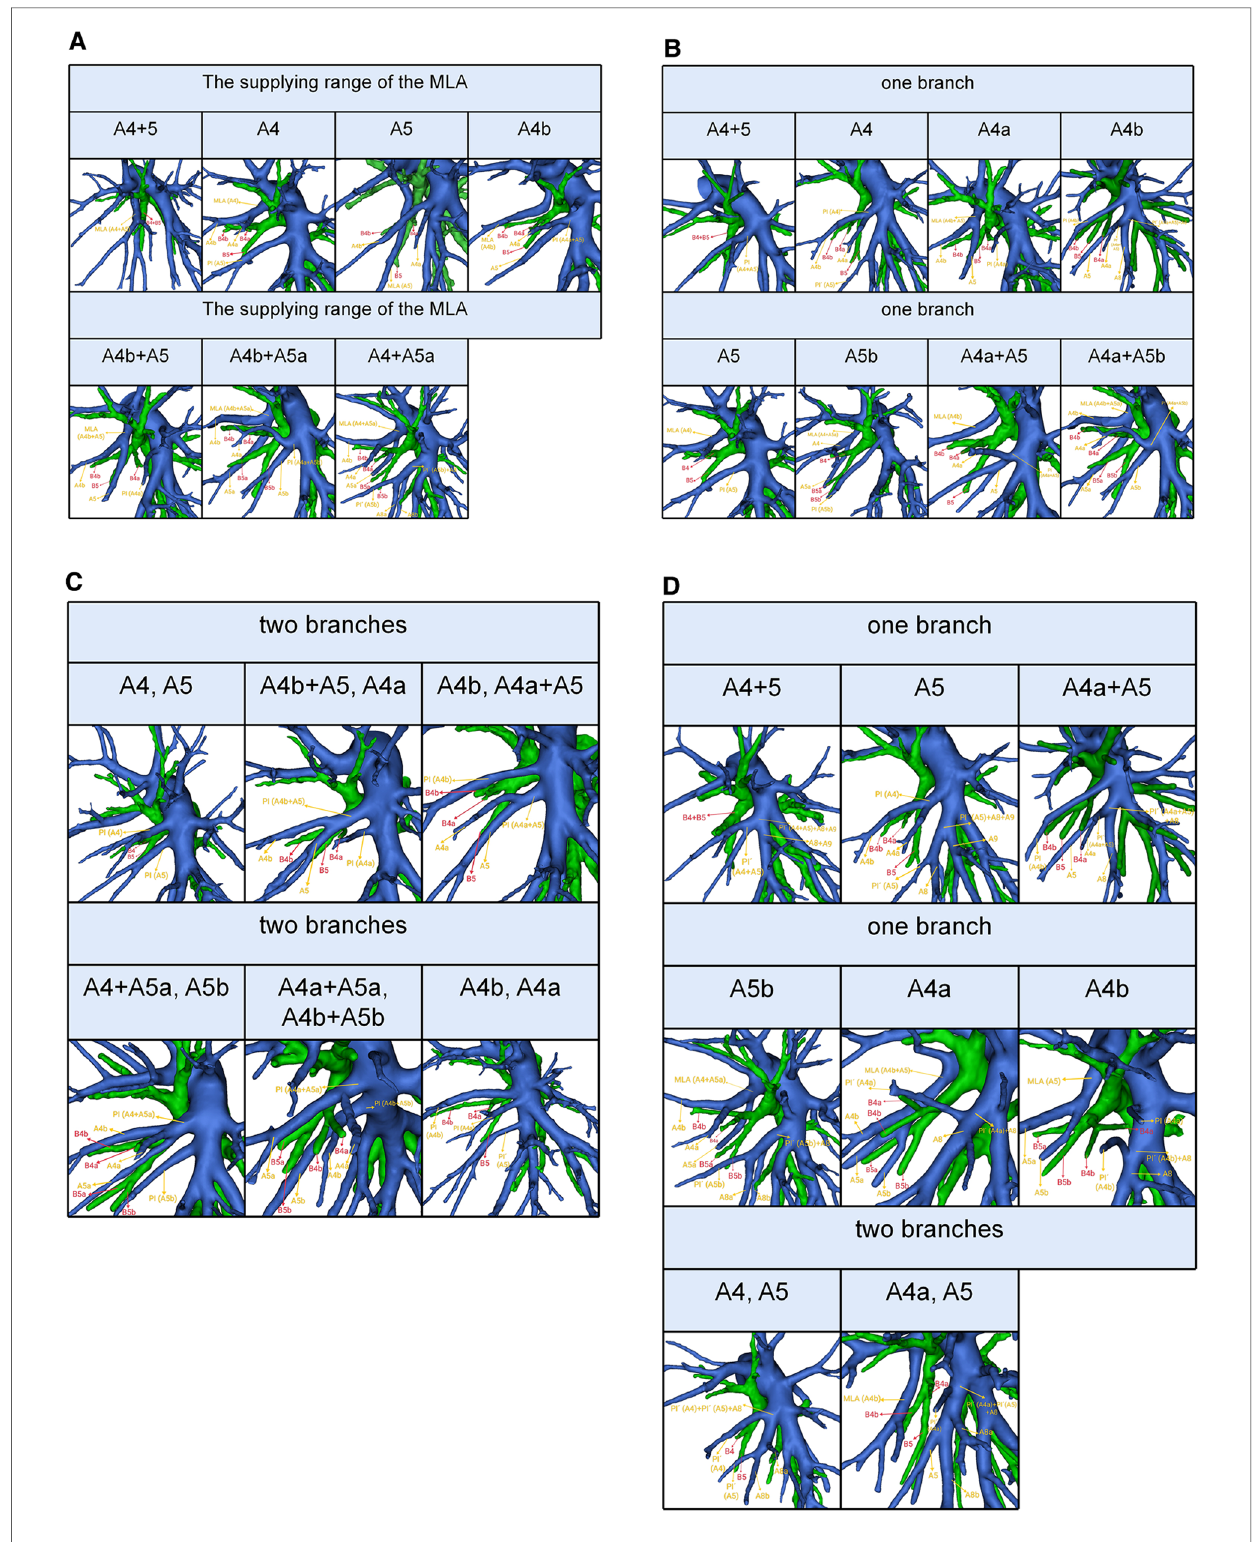
FIGURE 4 ( A ) 3D reconstruction model of the supplying range of the MLA. ( B ) 3D reconstruction model of the supplying range of the one branch PI. ( C ) 3D reconstruction model of the supplying range of the two branches PI. ( D ) 3D reconstruction model of the supplying range of the